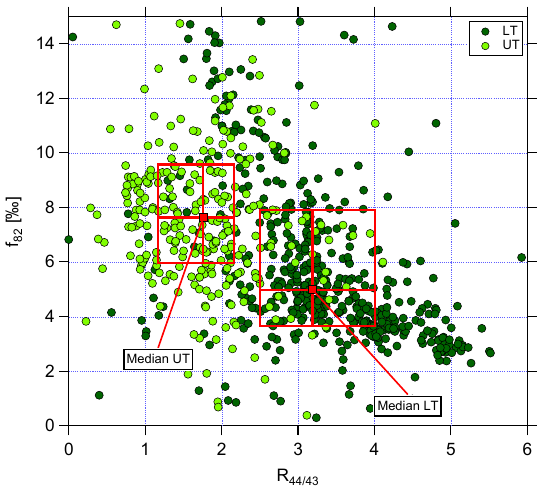
Figure 7. Scatter plot of f 82 against R 44 / 43 for the lower tropo- sphere (dark green, LT) and upper troposphere (light green, UT). Data are averaged over 2min. Red markers and boxes show median values and interquartile ranges for LT and UT,